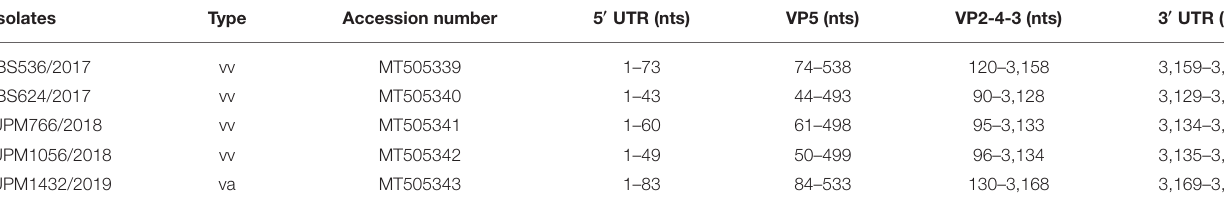
TABLE 1 | Complete genome annotation sequences of segment A of the study IBD viruses. Isolates